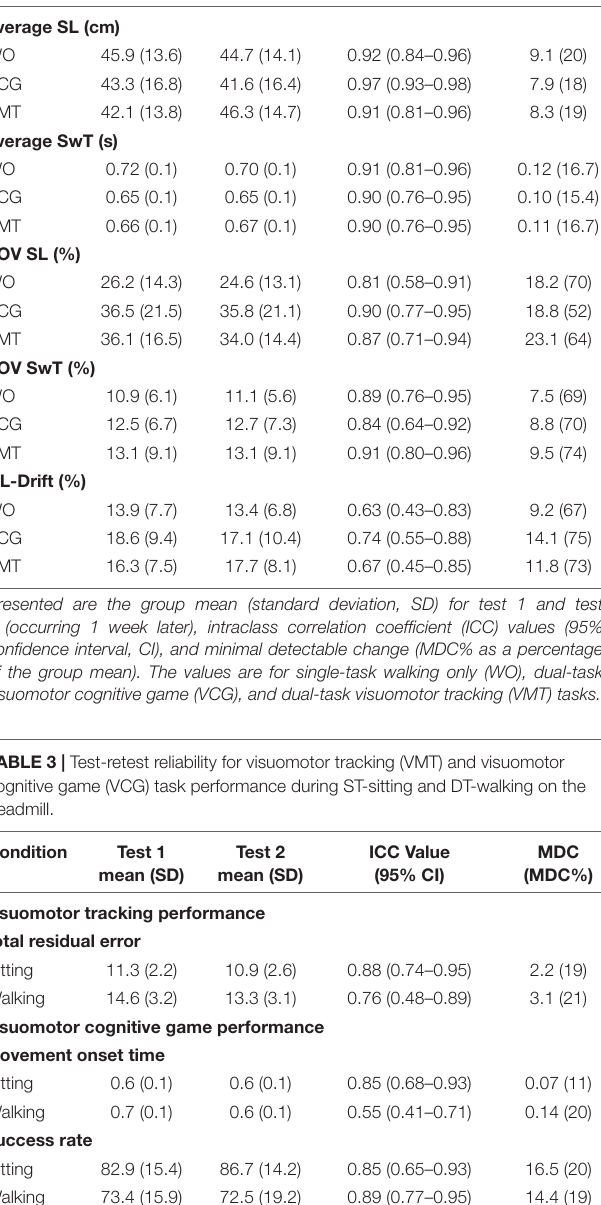
TABLE 2 | Test-retest reliability results for spatial and temporal gait outcome measures (average and COV).